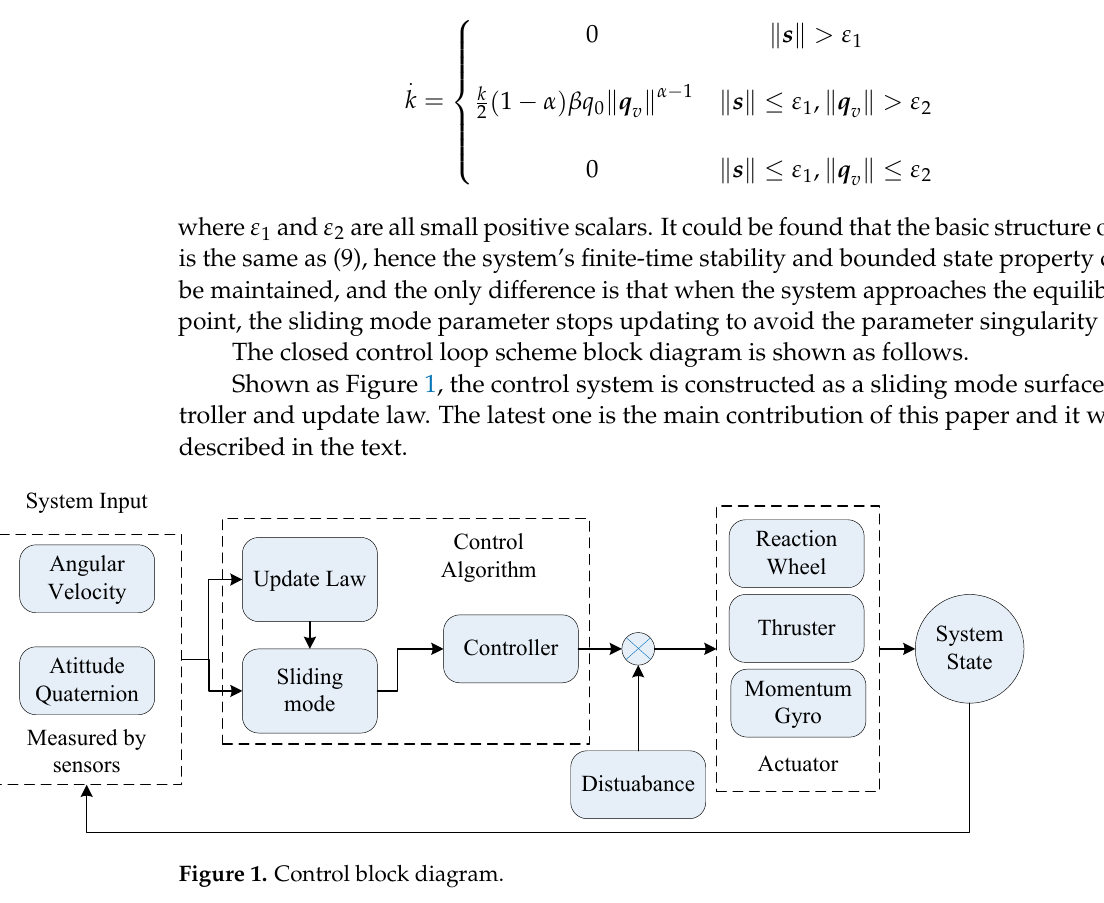
Figure 1. Control block diagram.